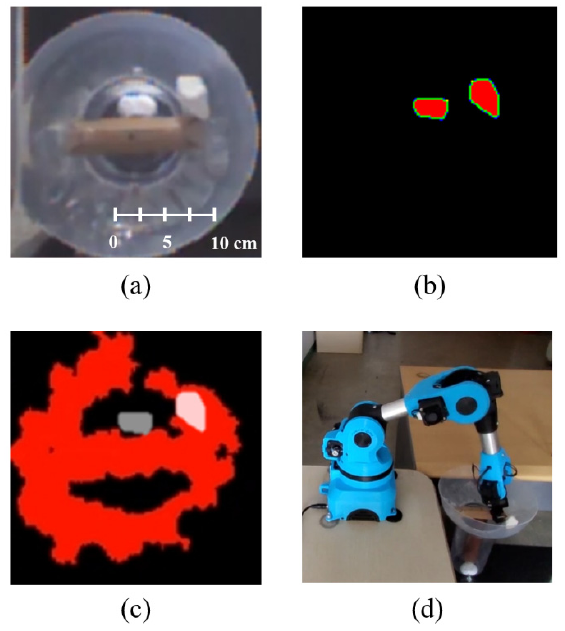
Figure 12. Experimental results obtained using the proposed smart hopper system in the case involving one rock under the hopper and one above the hopper (on the edge of the hopper). ( a ) RGB image, ( b ) detected rock in the binary image ( c ) classified rock based on depth image, and ( d ) operation of the robot arm.